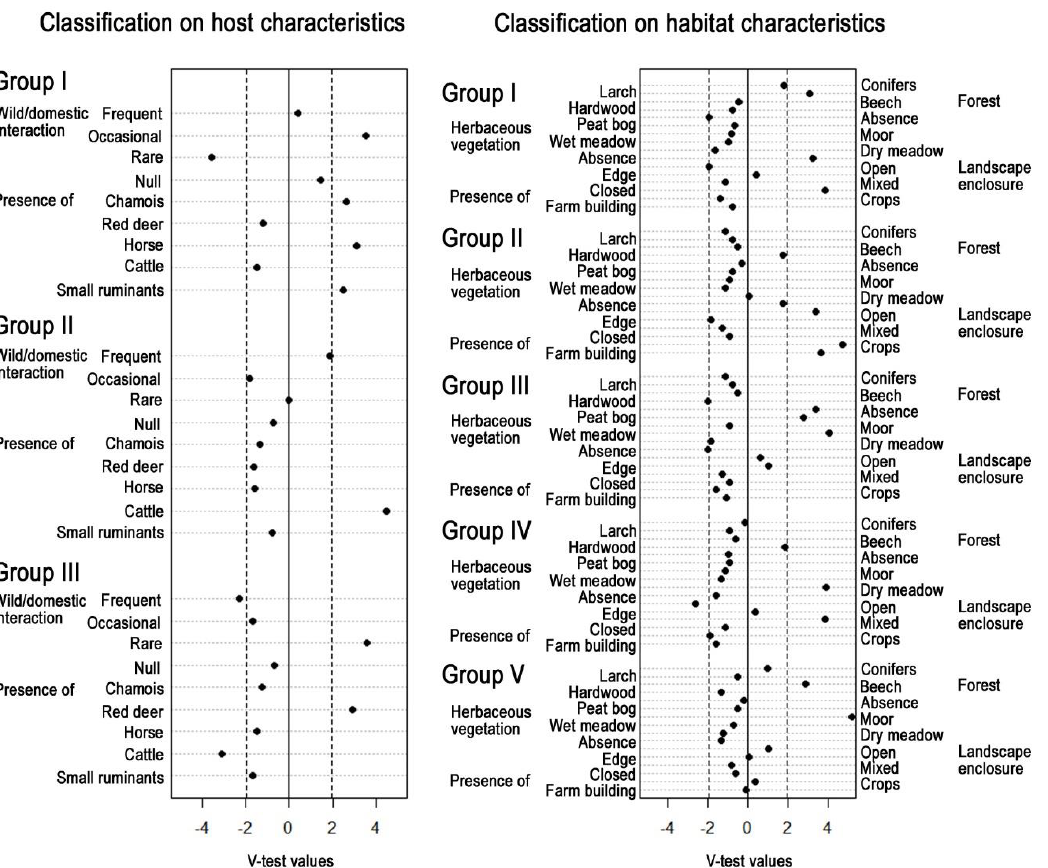
Figure 3. Description of the classifications related to host or environmental characteristics of the collection sites, using test values (measure of the distance between within-group and overall values) for each variable. Groups were obtained using a hierarchical cluster analysis, with the Ward minimum variance method, on the Euclidian distance matrix of the variable coordinates in a multiple correspondence analysis on host or habitat characteristics.